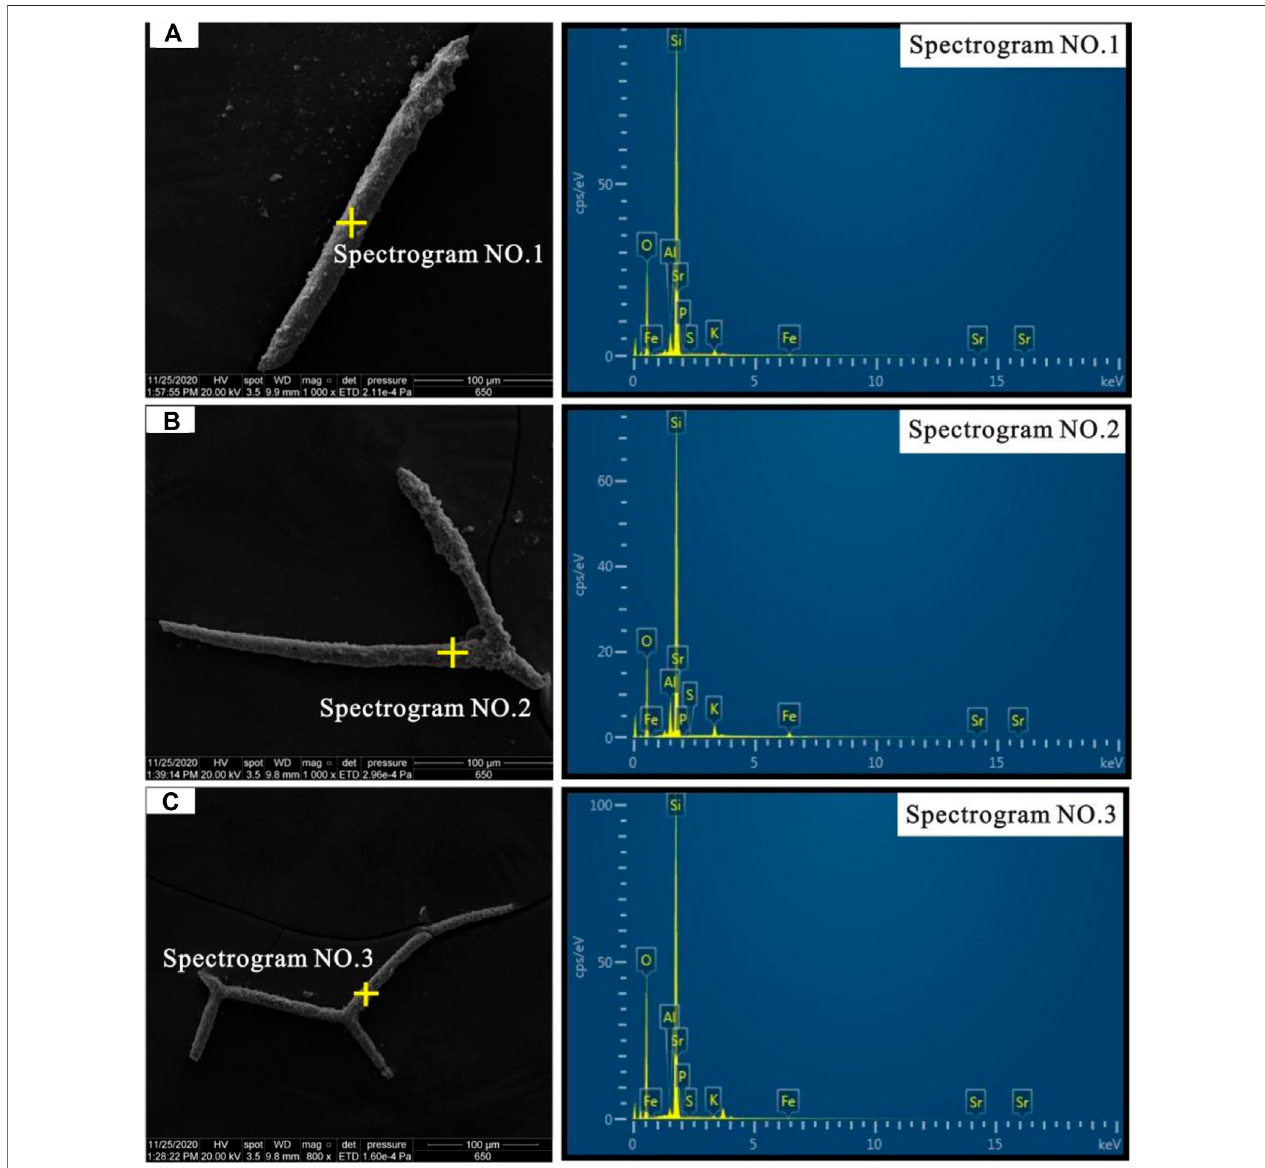
FIGURE 9 | Scanning electron microscope and energy spectrum analysis of